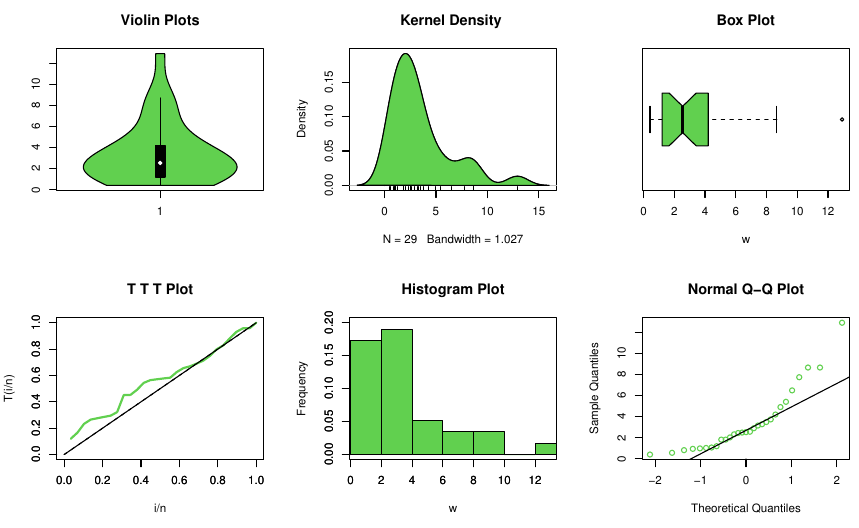
Figure 5. Non-parametric plots for data set III.